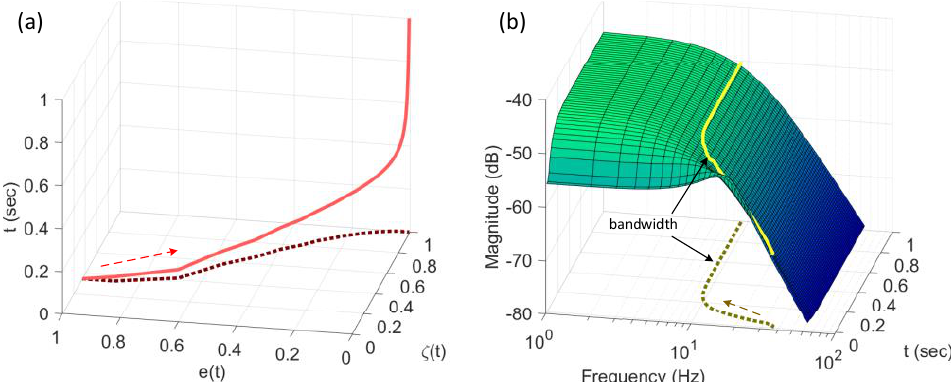
Figure 16. Variations of properties of the controlled compensated system: ( a ) dynamic damping ratio 𝜁(𝑡) (from 0.35 to 1) with respect to error and time (the dot line is the projection plot of 𝜁(𝑡) on error-damping ratio plane), and ( b ) 3D sketch of dynamic magnitude plot of the system and dynamic bandwidth 𝜔 𝐵𝑊 (𝑡) (yellow curve, from 35.62 Hz to ~9 Hz) at each time interval (the dot line is the projection plot of 𝜔 𝐵𝑊 (𝑡) on frequency – time plane).